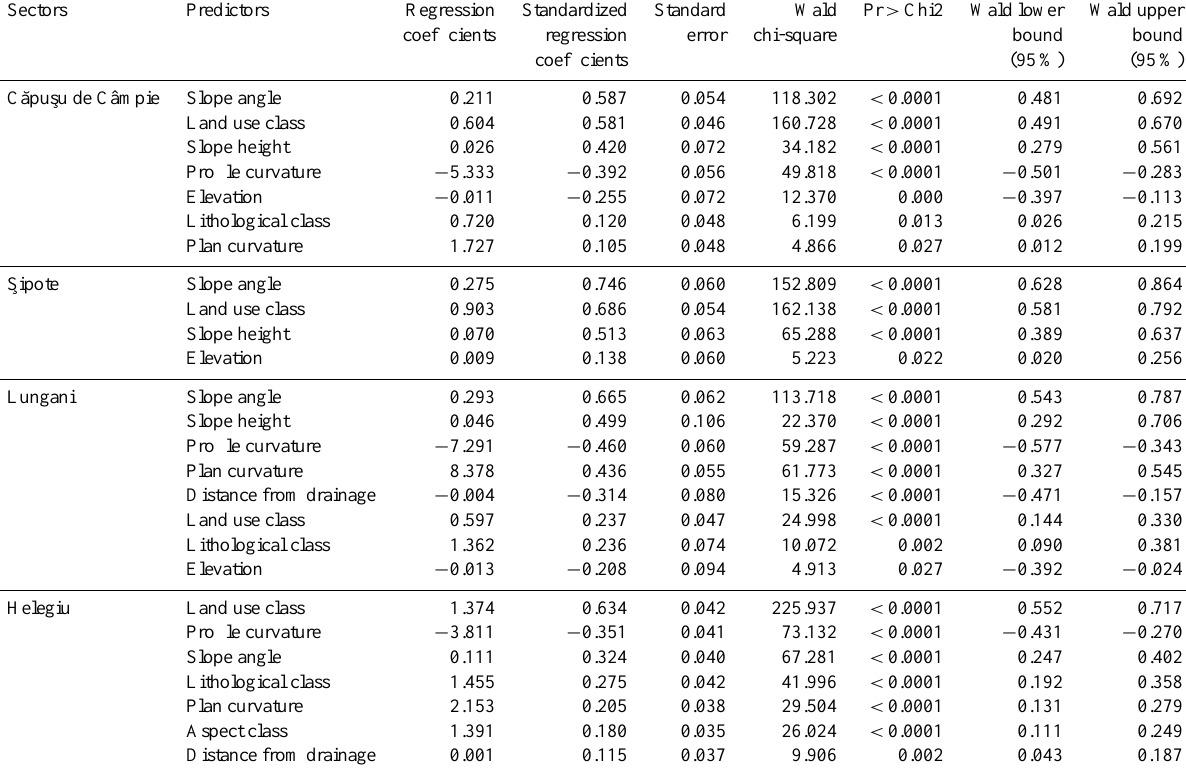
Table 4. Logistic regression (standardized) coefficients with predictors listed in order of decreasing importance. Sectors Predictors Regression Standardized Standard Wald upper coefficients regression error chi-square bound bound coefficients C˘apu¸su de Câmpie